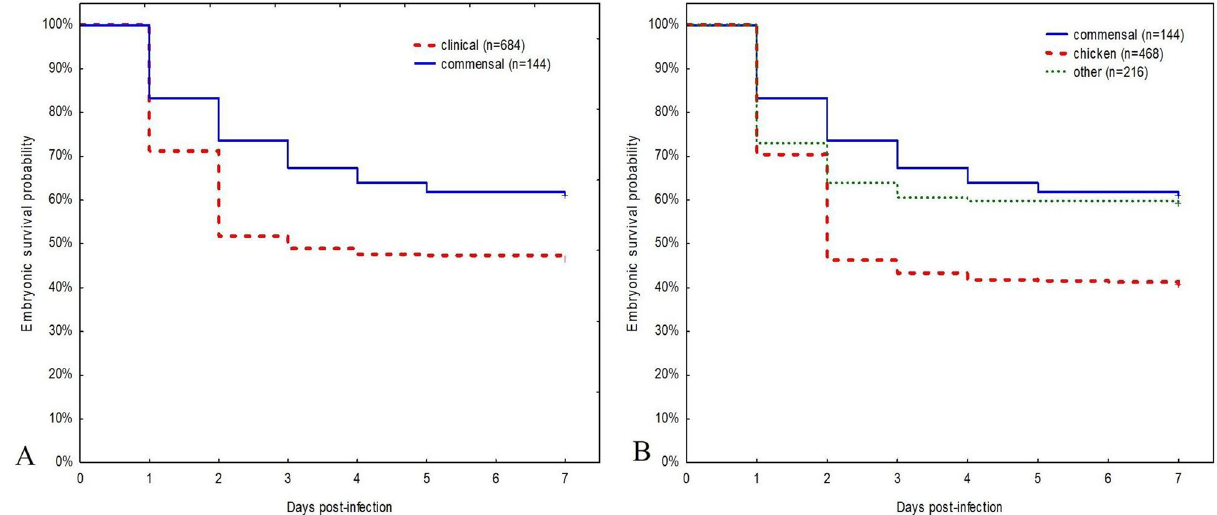
Figure 2. Survival analysis of SPF chicken embryos inoculated with Enterococcus cecorum . (A) survival comparison between clinical and commensal E. cecorum strains (B) survival comparison between clinical chicken isolates (CB, BB, CL), clinical non-chicken isolates (T, W) and commensal E. cecorum